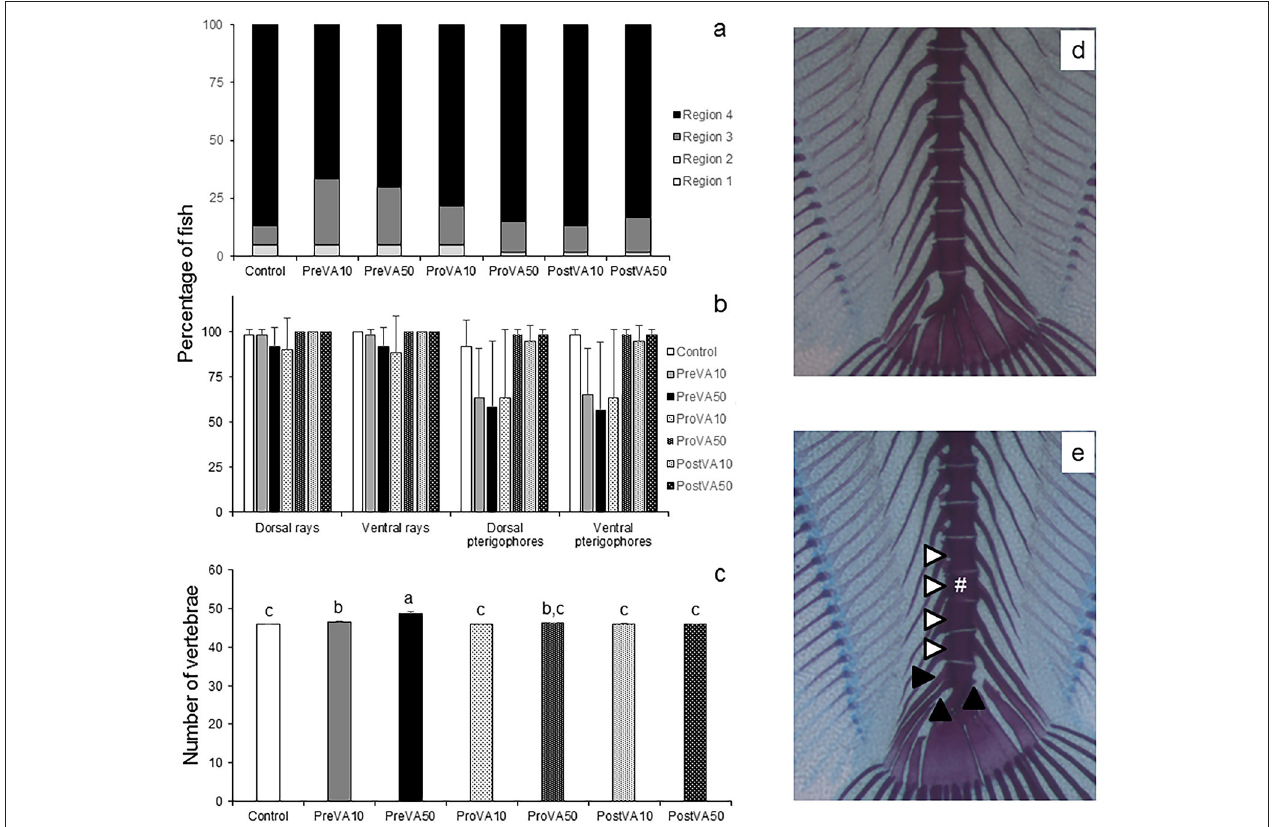
FIGURE 5 | Mineralization degree of different skeletal structures and mean number of vertebrae in 55 dph Senegalese sole larvae fed increased dietary vitamin A levels at different developmental stages. Percentage of larvae showing mineralization in cranial regions (R1, R2, R3, and R4; please see further information in Supplementary Figure 2) (a) , dorsal and ventral rays and pterigophores (b) and mean number of vertebrae (c) . A detailed view of the caudal fin complex from Control (d) and PreVA50 (e) fish at 55 dph is presented. Note the additional presence of a preural vertebrae (white #) and the related vertebral compression in preural vertebrae (white arrowheads), and the presence of neural and haemal spines in the urostyle (black arrowheads) in PreVA50 fish compared with the Control fish. For a detailed description about the different experimental groups, please see the legend of Figure 1 . Different letters at the top of each bar in graph (c) denote statistically significant differences among experimental groups (ANOVA, P < 0.05; N =